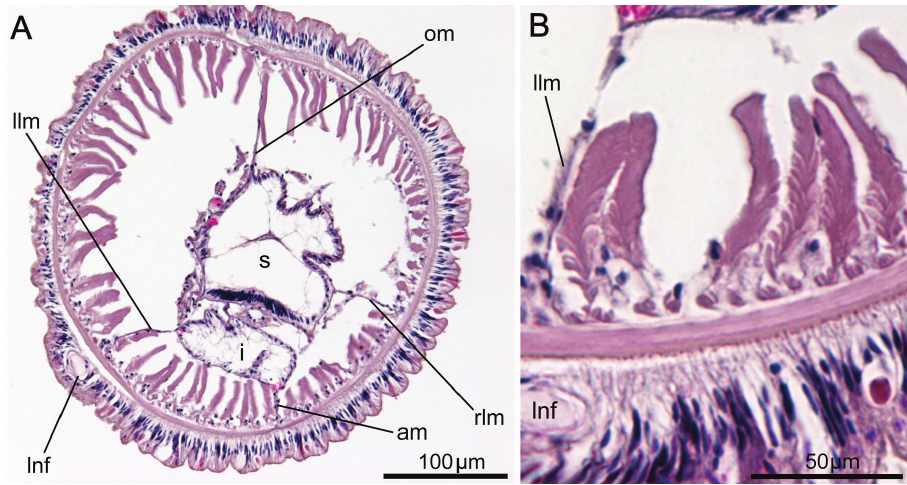
Figure 11. Phoronis emigi sp. n., NSMT-719 (paratype). A Transverse section through the posterior part of the body, showing four mesenteries and the position of the giant nerve fiber B enlargement of longi- tudinal muscles of the long feathery type. Abbreviations: am anal mesentery; lnf left giant nerve fiber; i intestine; llm left lateral mesentery; om oral mesentery; rlm right lateral mesentery; s